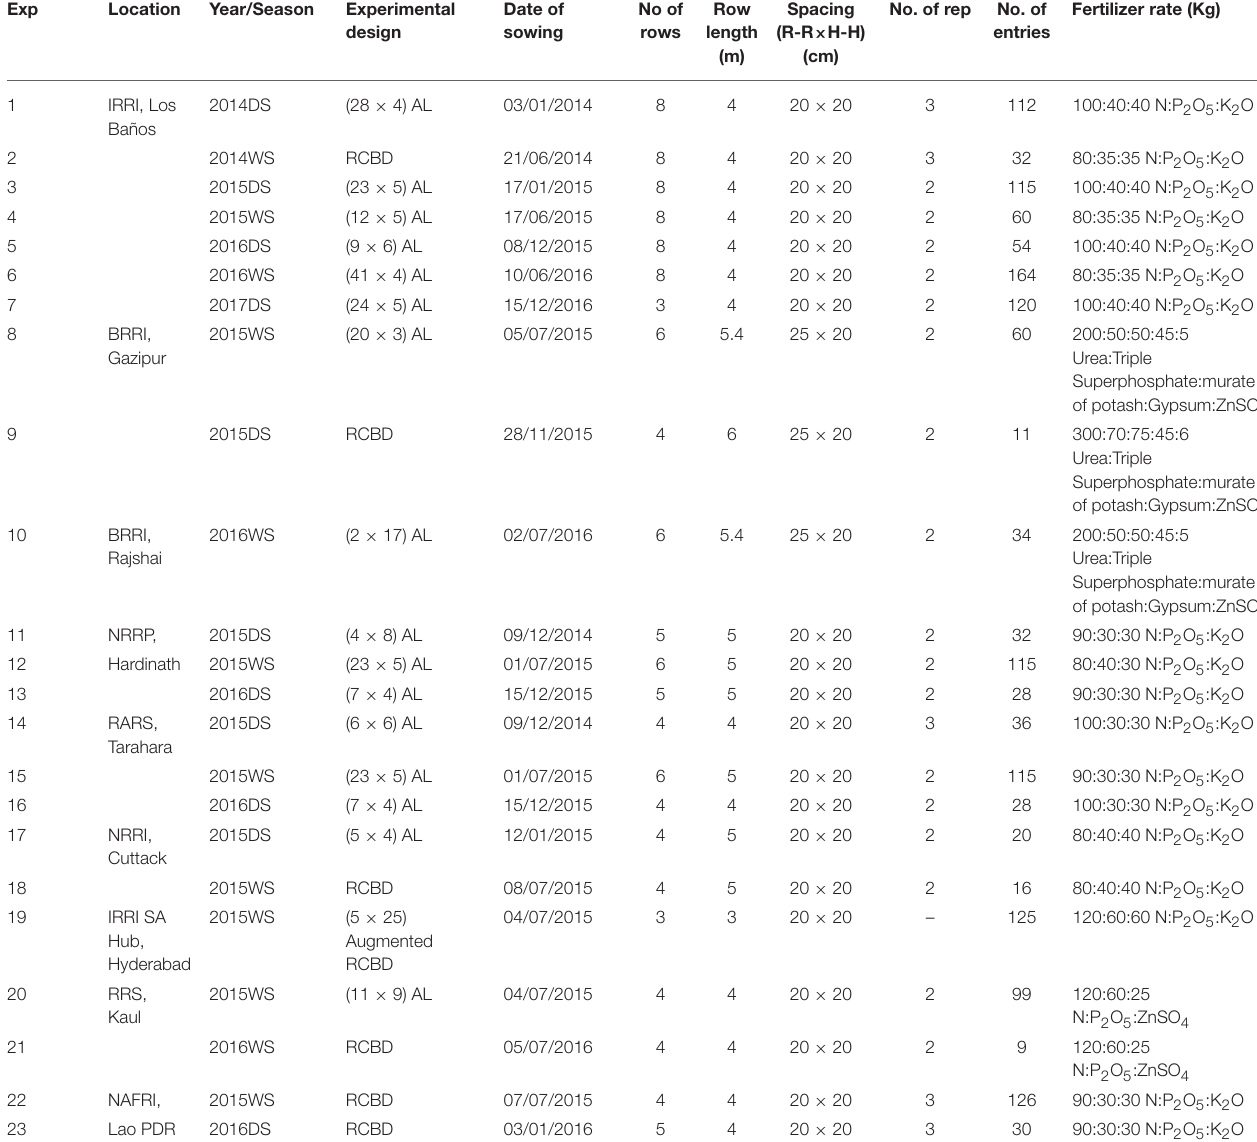
TABLE 2 | Details of the experiments conducted in 2014–17 across different ecosystems, seasons and years. Exp